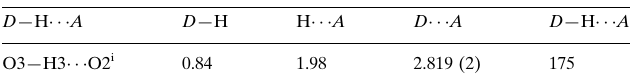
Hydrogen-bond geometry (A˚ , (cid:2)